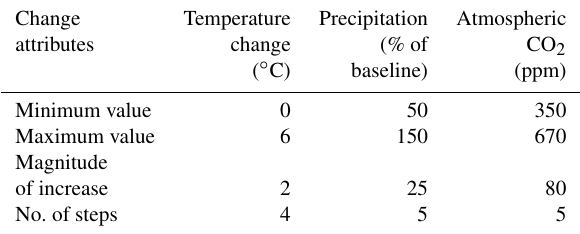
Table A1. Minimum and maximum stepwise changes in the climate variables and [CO 2 ]. The magnitudes of increases are related to how much a variable could be adjusted. Temperature was increased in four steps and the other variables in five steps resulting in 100 dif- ferent climate change